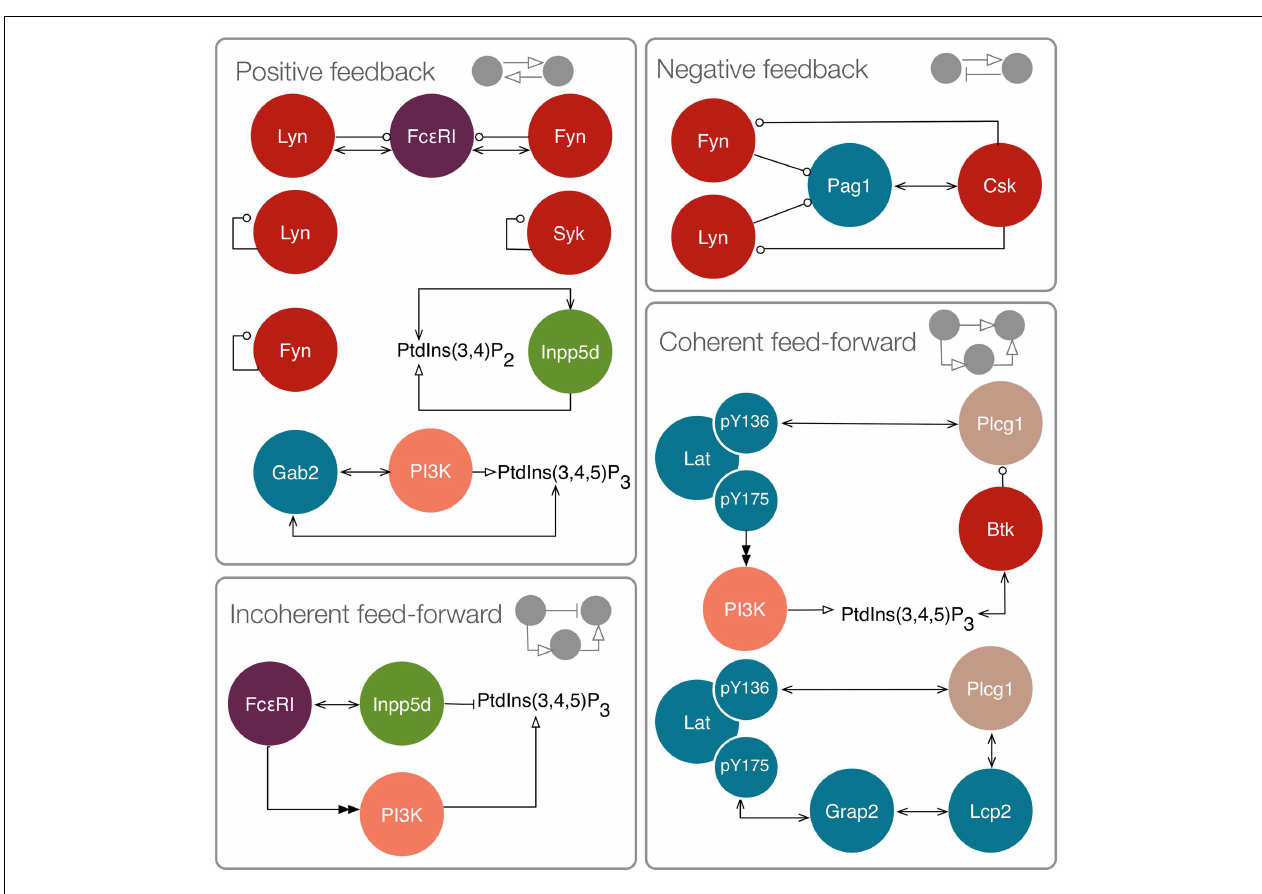
which can recruit additional Gab2. Negative feedback includes inhibition of Lyn and Fyn by Csk. Incoherent feed-forward includes Fc ε RI stimulation leading to activation of both PI3K and Inpp5d, which exert opposing influences on PIP 3 level. Coherent feed-forwards include recruitment and activation of Plcg1, and recruitment of Plcg1 through two pathways.